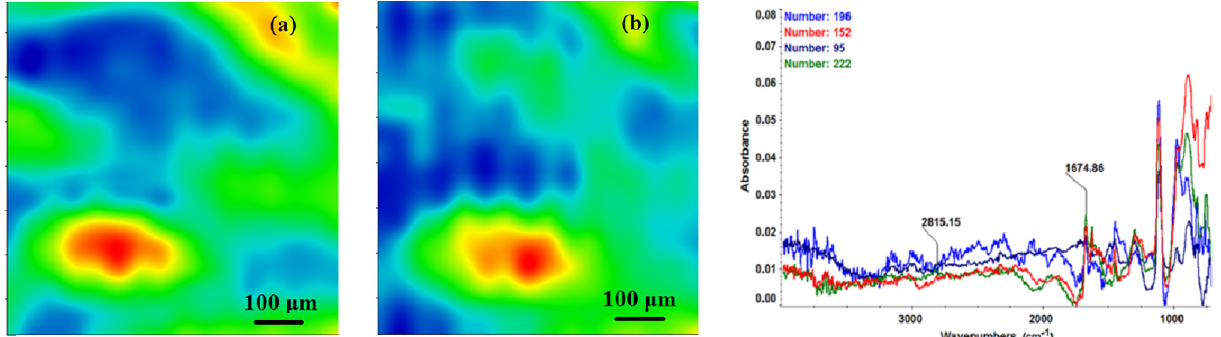
Figure 5. Second derivate IR mappings and IR spectra of thin coating (F = 500 mJ/cm 2 ) surface: intensity distribution of ( a ) 2815 cm